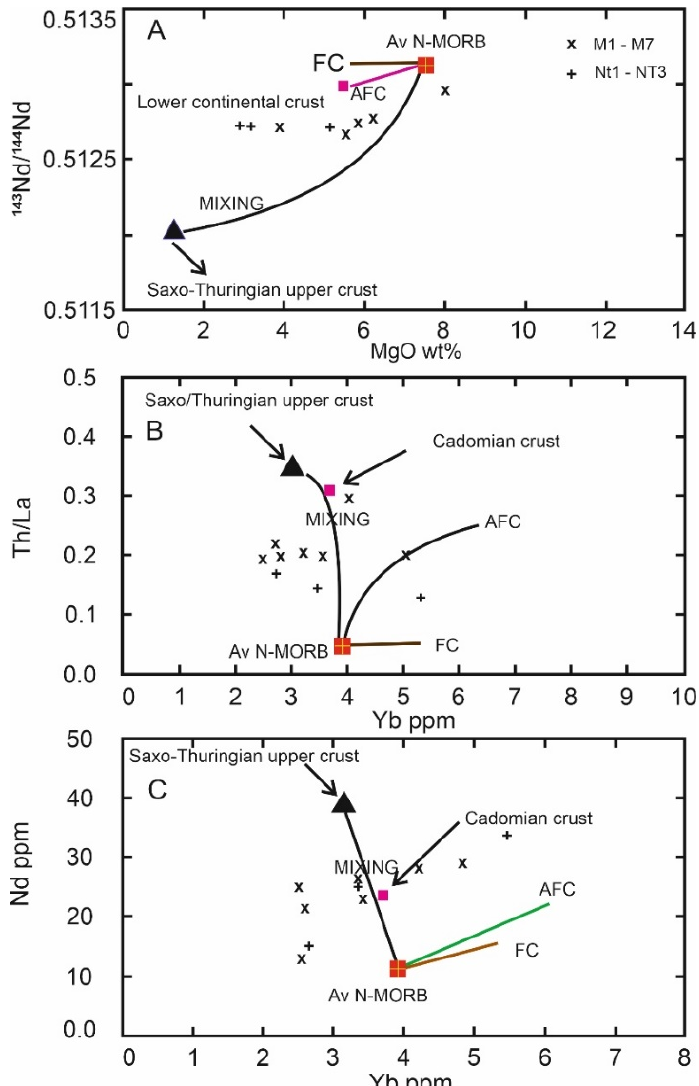
Figure 14. ( A ) 143Nd/144Nd vs. MgO; ( B ) Th/La vs. Yb; ( C ) Nd vs. Yb plots showing the results of FC, AFC, and mixing modeling results. N-MORB average is from Hofmann [72] and Ito et al. [73]. Saxo-Thuringian upper crust from Romer and Hahne [68], average lower continental crust from Taylor and McLennan [74] and Cadomian crust from Linnemann and Romer [75]. AFC—assimilation with fractional crystallization, FC—fractional crystallization. Others from Abdelfadil et al. [76]. Sample M-1—M7 from Tables 7 and 8, NT—analyses of paleobasalts from Vozár et al. [61].